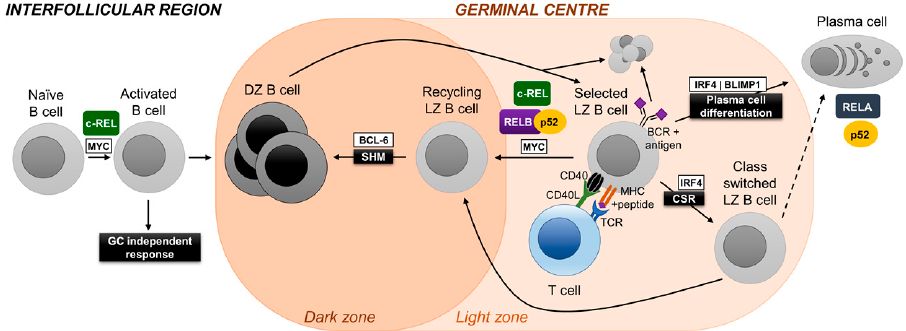
Figure 2. Role of NF- κ B subunits in the molecular control of germinal center (GC) initiation, maintenance and differentiation. High-affinity PCs and memory B cells are generated in the GC B-cell reaction (see text). At day 7 of the GC response, a mature, polarized GC microenvironment is formed which comprises of a dark zone and a light zone. Dark zone GC B cells somatically hypermutate their immunoglobulin variable (IgV) genes and move to the light zone where B cells are selected for improved antibody affinity, a process that involves follicular dendritic cells and T follicular helper (Tfh) cells. Positively selected B cells either recirculate back to the dark zone to undergo further rounds of proliferation and IgV hypermutation, or differentiate into PCs and memory B cells. c-REL is required for B-cell activation, whereas RELA is dispensable at this stage. c-REL, and independently RELB/p52, are required for the recirculation of an antigen-selected GC B cell from light to dark zone, and thus for the maintenance of the GC reaction. Conversely, RELA is required for the differentiation of a GC B cell into a PC precursor (plasmablast). The p52 subunit alone (i.e., it does not require RELB) is essential for the physiology of PCs. Figure adapted from [21].